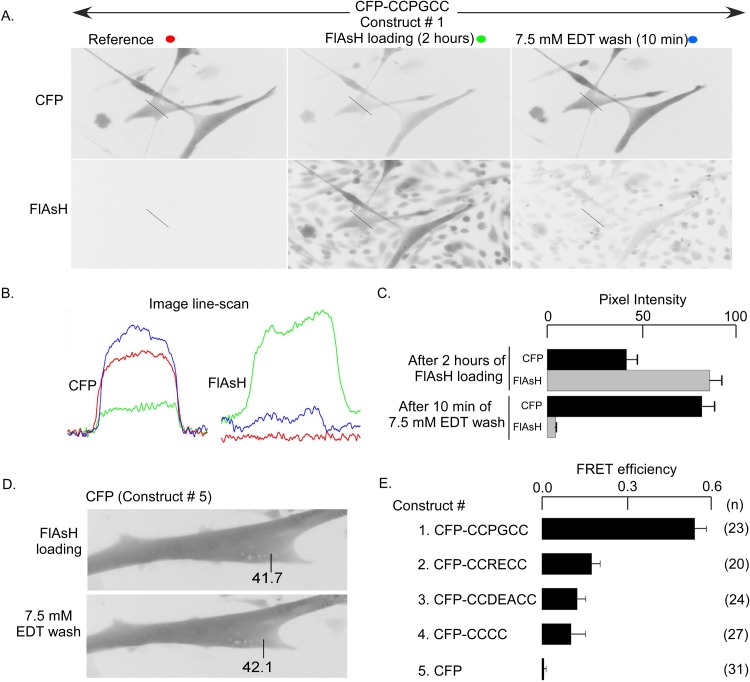
FRET signals in myotubes expressing CFP-CCXXCC and WT CFP.(A) CFP-CCPGCC concatamer (construct 1) transfected myotubes show a high level of CFP expression as indicated by fluorescence in the CFP channel. Before FlAsH loading there was no fluorescence in the FLUO channel for the reference condition (red circle, left panels). After 2 hrs of incubation in 1 μM FlAsH to load the tetracysteine motif, fluorescence in the CFP channel decreased and in the FLUO channel increased (green circle, middle panel). Incubation with 7.5 mM EDT for 10 minutes to displace FlAsH from the tetracysteine tag reversed the fluorescence changes back toward the reference conditions (blue circle, right panels). (B) Pixel intensity of a line scan across the myotube (straight line indicated in each panel of A) in the CFP versus FLUO channels. Colors of traces correspond to color markings in A. (C) Summary of mean pixel intensities of CFP-CCPGCC concatamer (construct 1) expressed in myotubes. (D) WT-CFP (construct 5) transfected myotubes (without the tetracysteine tag) show no change in CFP fluorescence after 1 μM FlAsH loading or after 7.5 mM EDT wash. The number represents the fluorescence intensity (CFP) of a particular region in the myotube. (E) FRET vs FlAsH binding sequences showing CFP-CCPGCC (construct 1) FlAsH complex. Highest FRET efficiency (0.52 ± 0.04) was observed with CFP-CCPGCC (construct 1) than CFP-CCRECC (construct 2, 0.17±0.03), CFP-CCDAECC (construct 3, 0.12 ± 0.03), CFP-CCCC (construct 4, 0.10 ± 0.05) or untagged CFP-CFP (construct 5, 0.07 ± 0.01). Total number of cells (n) analyzed is shown within brackets.